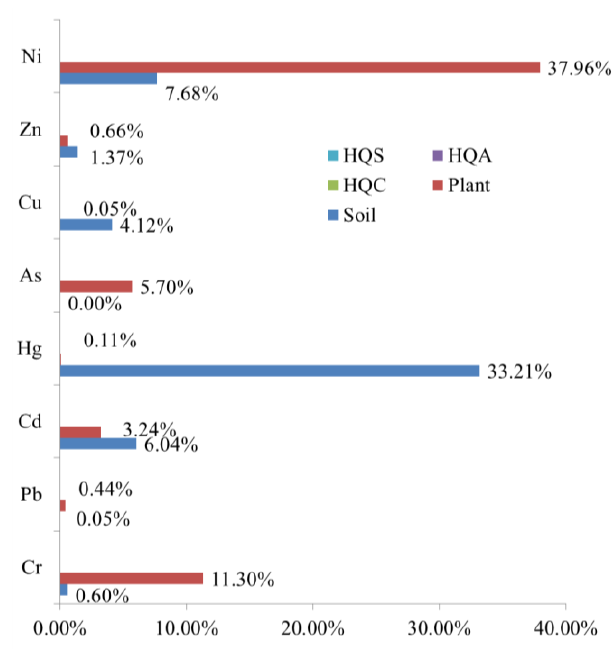
Figure 9. Comparison of the standard exceeding rates of SPI, CPI, and HQ for different heavy metals.